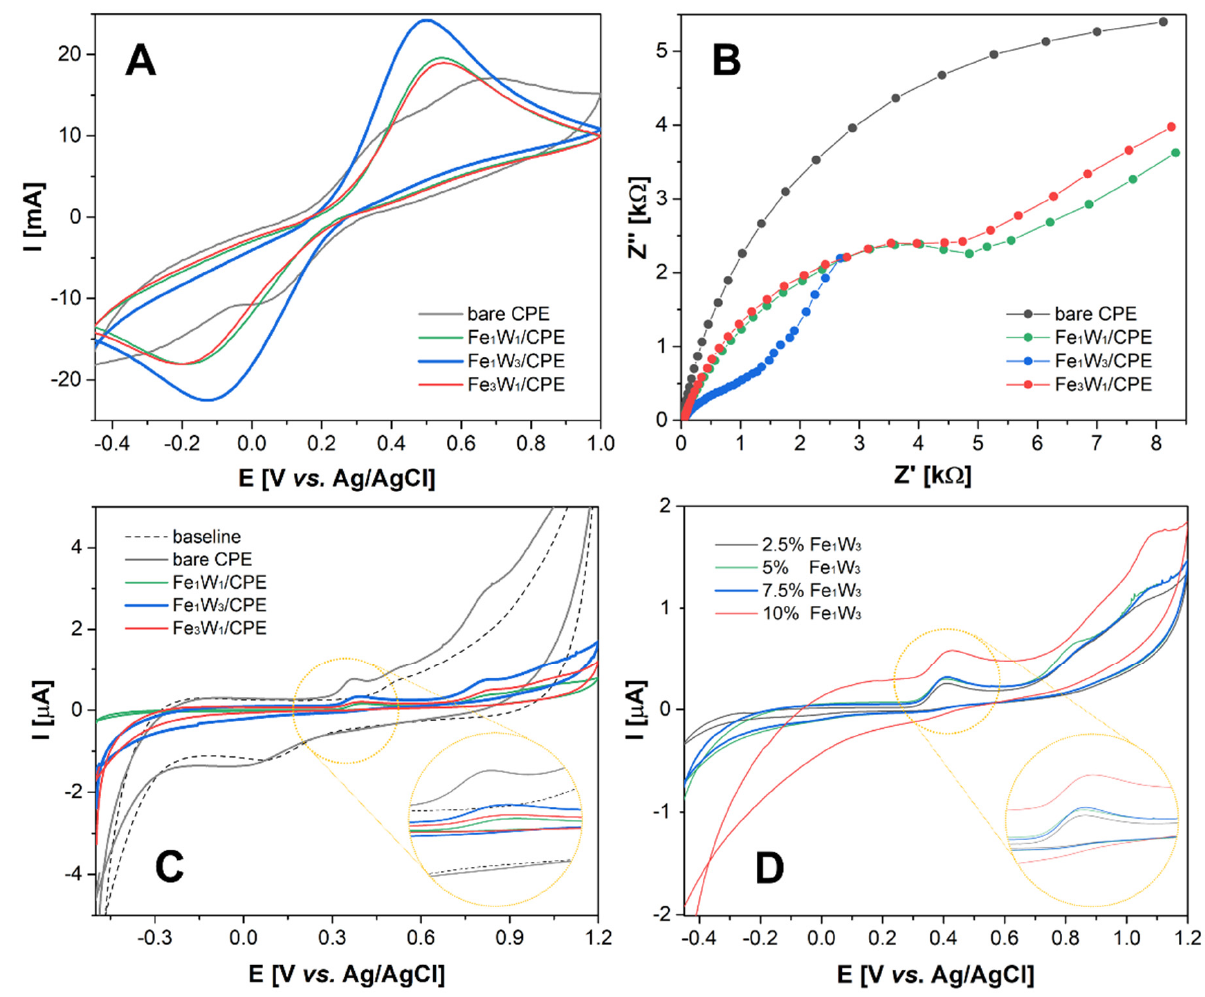
Figure 3. ( A ) CVs of 5 mM K 3 [Fe(CN)] 6 /K 4 [Fe(CN)] 6 (1:1) at unmodified CPE, Fe 1 W 1 –, Fe 1 W 3 –